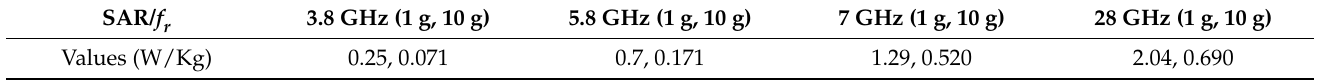
Table 2. Specific absorption rate (SAR) values at different frequencies and standards.